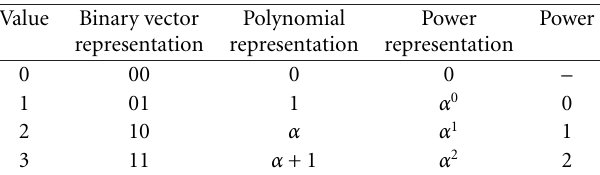
Table 1: Element representation in GF(4).